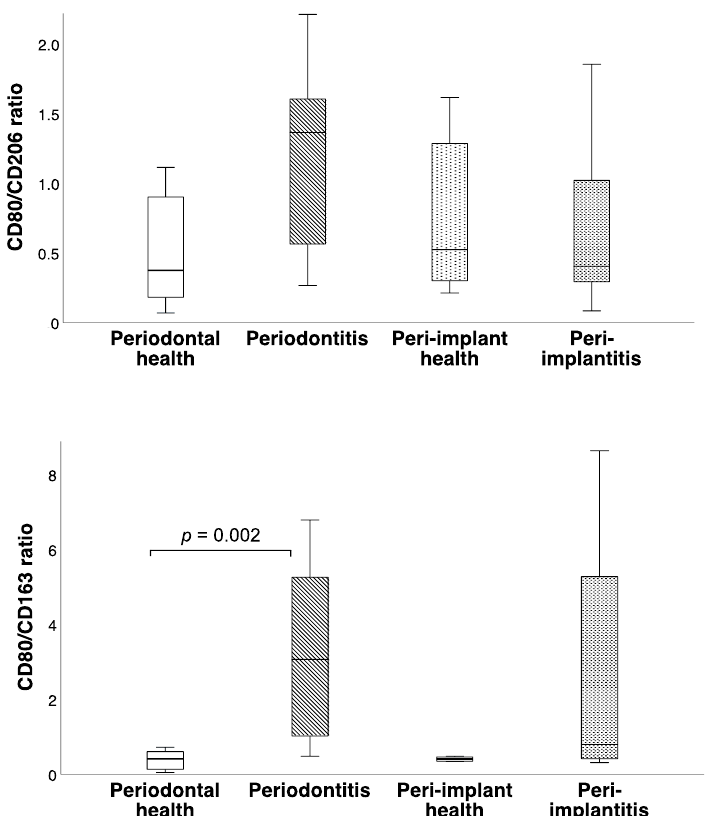
Figure 2. Box-and-whisker diagrams of CD80/CD206, CD80/CD163 ratios according to the groups. The CD80/CD163 ratio was lower in periodontally healthy participants when compared to those with periodontitis, while there was no significant difference between participants with healthy peri-implant mucosa and those with peri-implantitis. The CD80/CD206 ratio was similar among groups. Horizontal lines represent the 25th, 50th, and 75th percentiles. p -values represent the statistical significance of pairwise comparisons.